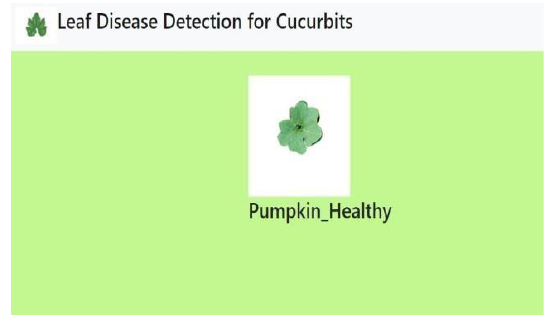
Fig 6. Conversion to grey scale